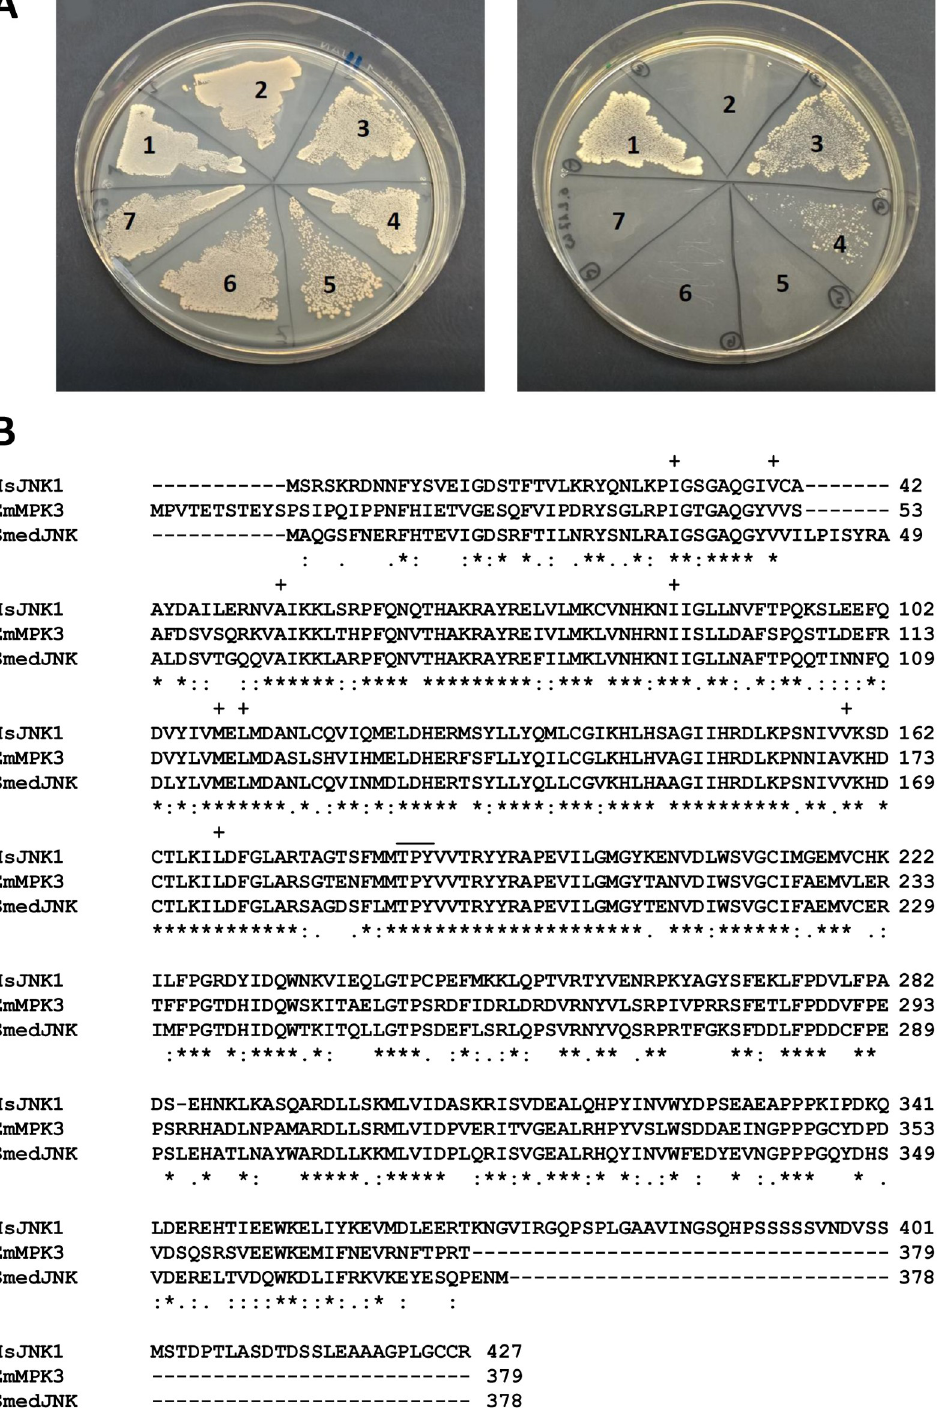
Fig 5. Sequence features and interactions of EmMPK3. A) Y2H experiment showing the interaction between EmMKK3 and EmMKK2 with EmMPK3. Left plate, SD-Leu-Trp for transfection control; right plate, SD-Leu-Trp-His with 7,5 mM 3-Amino-1,2,4-triazol. 1, positive control (T-antigen-AD x p53-BD); 2, negative control (T-antigen-AD x lamC-BD); 3, EmMKK2-AD x EmMPK3-BD; 4, EmMKK3-AD x EmMPK3-BD; 5, EmMKK2-AD x empty-BD; 6, EmMKK3-AD x empty-BD; 7, EmMPK3-BD x empty-AD. B) Amino acid sequence alignment of JNK of different origin. Compared are the sequences of E . multilocularis EmMPK3 (this work; accession no. MW358638), human